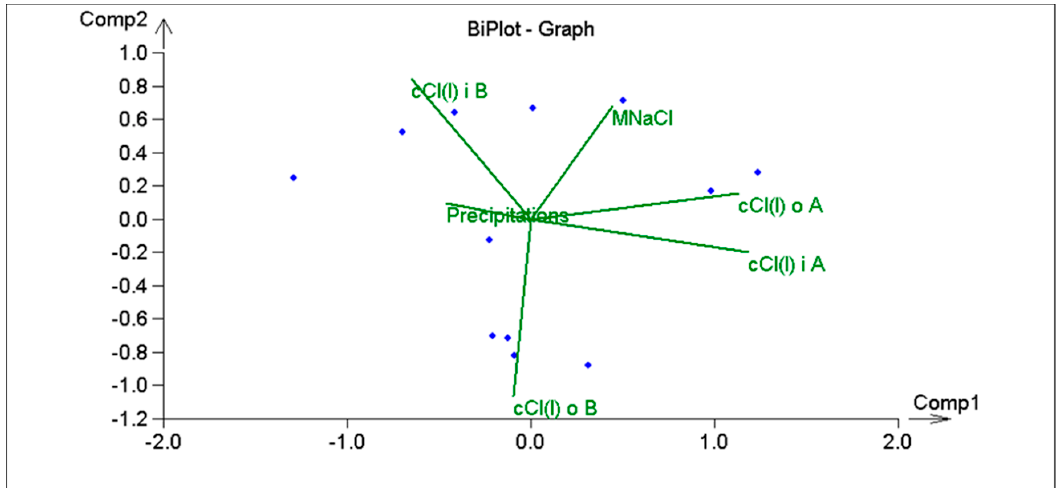
Figure 12. Relationships between variables shown in the BiPlot chart for both sites.